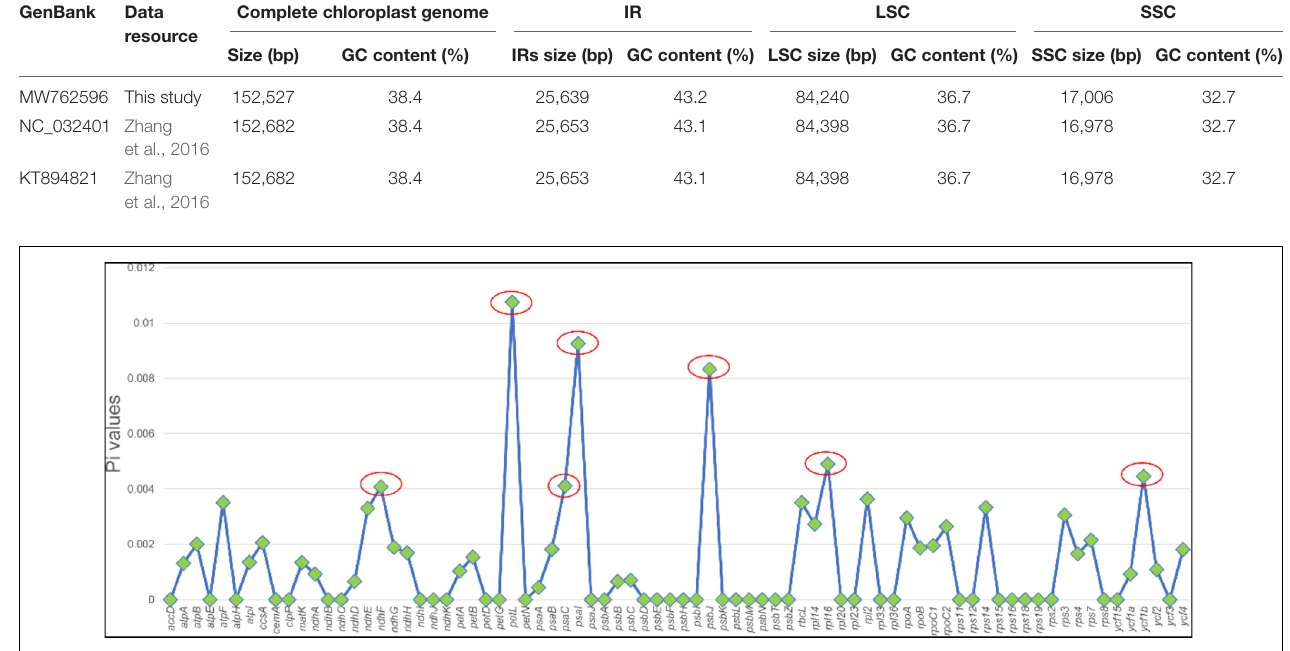
FIGURE 4 | Nucleotide diversity of different regions between Paeonia lactiflora and Paeonia veitchii chloroplast genome in this study. The x-axis shows chloroplast genome regions and the y-axis shows nucleotide diversity.